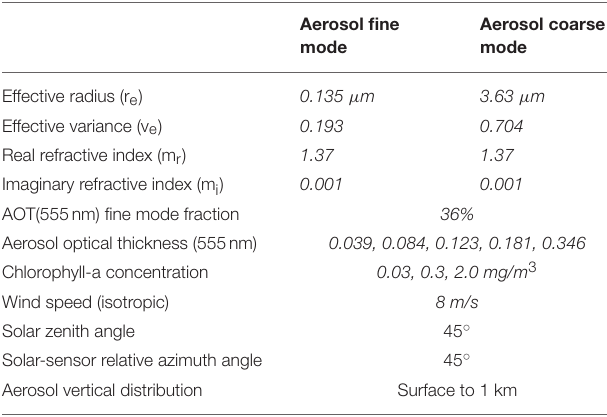
TABLE 2 | Scene parameterization for results in Figure 3